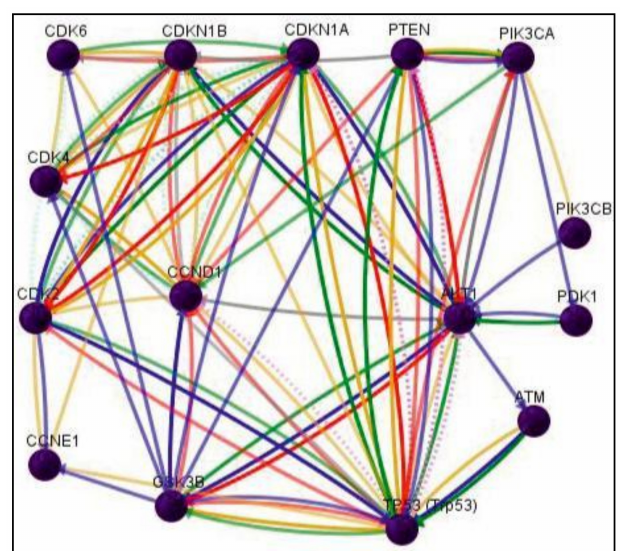
Figure 3. Molecular interactions between the studied genes. *The lines represent the down-regulation (red), up-regulation (green), functional and transcriptional regulation (grey), co-expression (purple), chemical modification (phosphorylation, post-transcriptional modifications, etc.) (blue), physical interaction (yellow), predicted protein interaction (pale-blue dotted line), and predicted transcription factor regulation (purple dotted line).